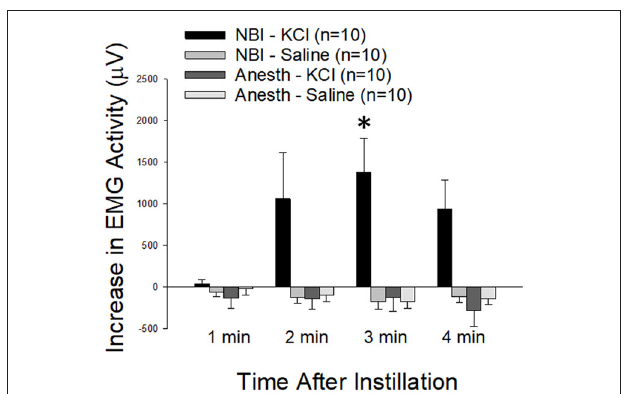
FIGURE 9 | Effect of NBI on Responsiveness to Intravesical Potassium Chloride Solutions. VMRs to the intravesical infusion of 100 microliters of either normal saline (Saline) or potassium chloride (KCl; 0.4mM) solutions measured as EMG activity averaged over 1min epochs differed between rats which experienced NBI vs. neonatal control (Anesth) treatments. * indicates statistically significant difference between the NBI-KCl group and all other measures at the 3min timepoint ( p < 0.01).